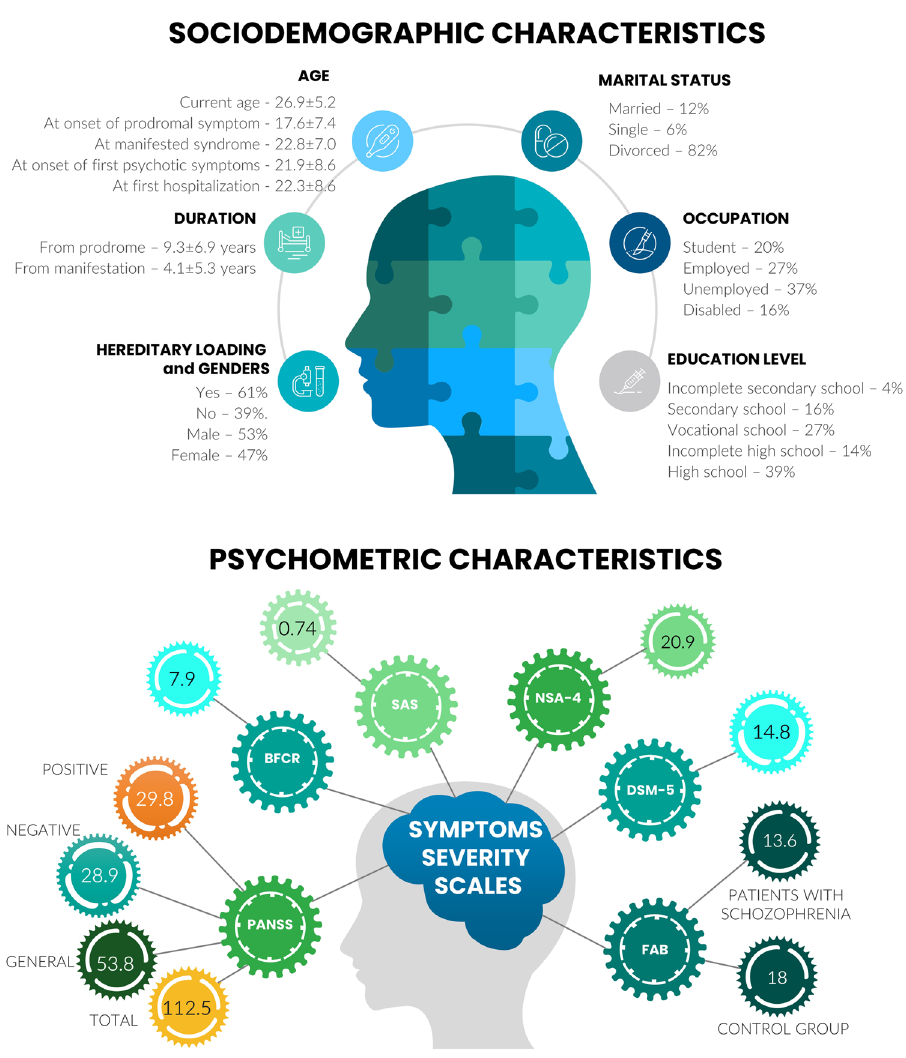
Figure 1. Main anthropometric and psychometric data accrued for subjects with schizophrenia (n = 49). Complete records can be appreciated in the Supplementary Appendix A (Demography) and include the corresponding characteristics for the control group of healthy donors (n = 50) and for the validating group of patients with schizophrenia (n = 28). All groups under consideration were aligned by age and genders ratio items. Both, study population and validating group were leveled in the duration from prodrome and the duration from manifestation. The hereditary loading was slightly inclined in the study cohort (61%) cmpare to the validating group (46%; see Supplementary Appendix A) however this did not affect the final results and conclusions. Subjects of study cohorts were tested with several scales to assess the severity and progression of symptoms (Mann–Whitney test at a raw p < 0.05): PANSS Positive and Negative Syndrome Scale, BFCR scale Bush–Francis Catatonia Rating Scale, NCS4 the 4-Item Negative Symptom Assessment, SAS Simpson-Angus Scale, DSM-5 Diagnostic and Statistical Manual of mental disorders, fifth edition, FAB Frontal Assessment